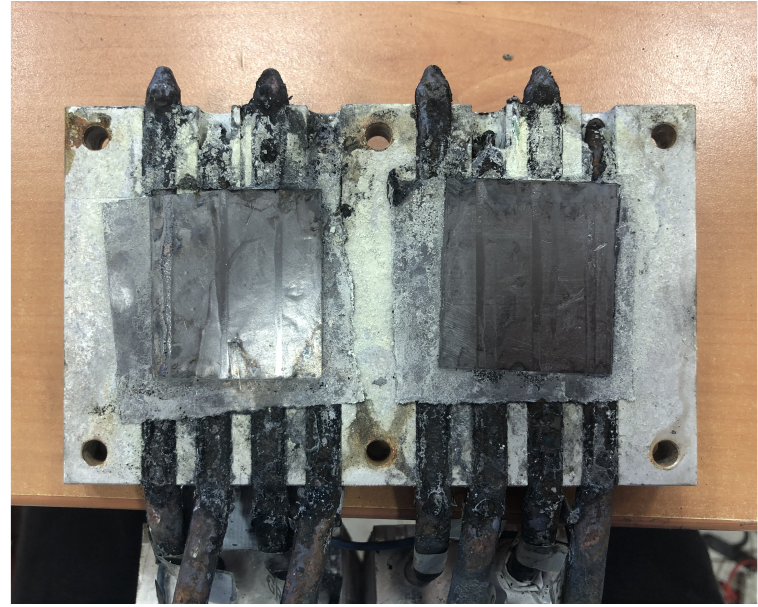
Figure 15. Corrosion of the cold side heat